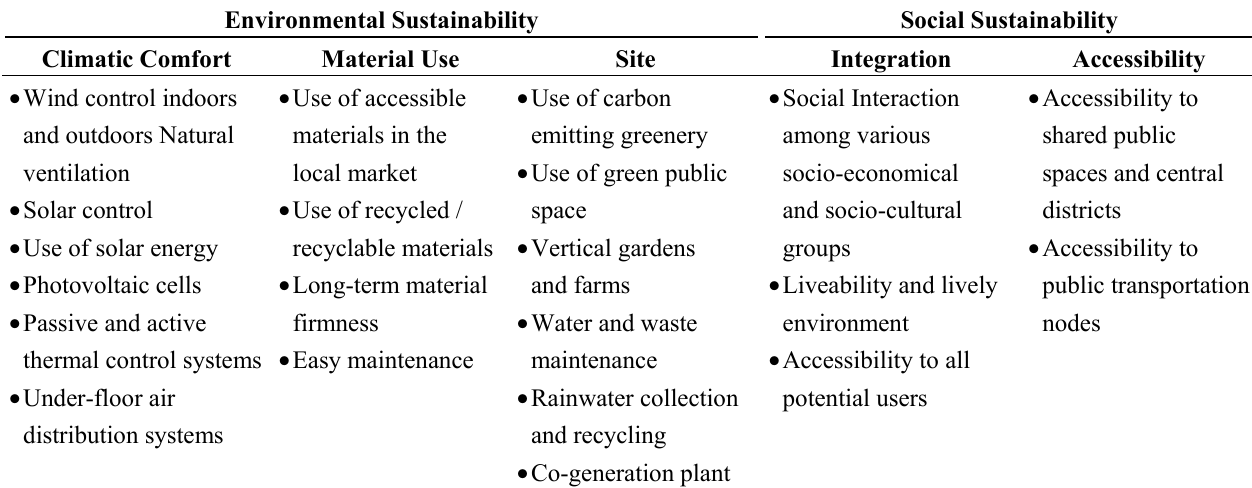
Table 1. Design parameters of